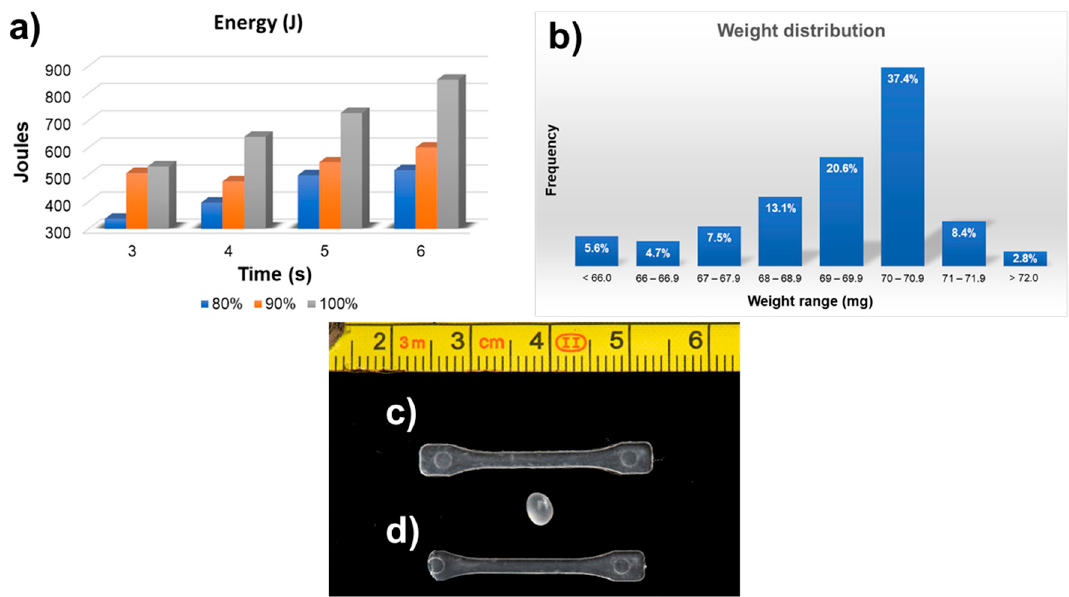
Figure 2. ( a ) Average energy from values displayed by the UMIM machine for each amplitude and time and ( b ) histogram of weight distribution for all the specimens fabricated in the study. Examples of ( c ) a “complete specimen” and ( d ) an “incomplete specimen”. A pellet of raw iPP is placed in between the specimens to visualize the size change after the UMIM processing.